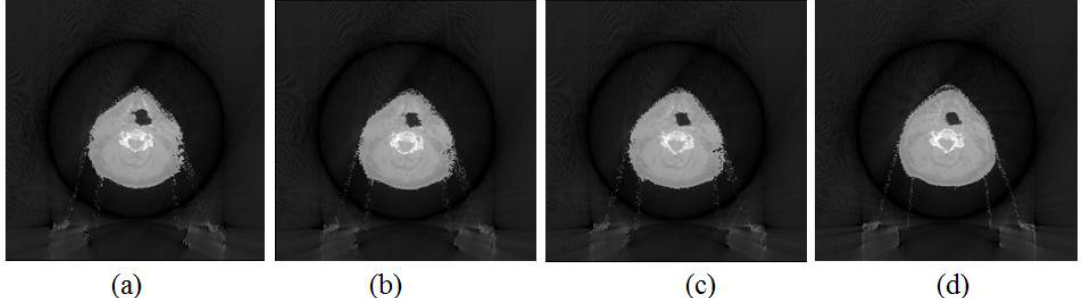
Figure 3. The images reconstructed with the deformation-based reconstruction method as de- scribed in Section 2.1. ( a ) Image reconstructed with 30° scan angle. ( b ) Image reconstructed with 45° scan angle. ( c ) Image reconstructed with 60° scan angle. ( d ) Image reconstructed with 90° scan an- gle.